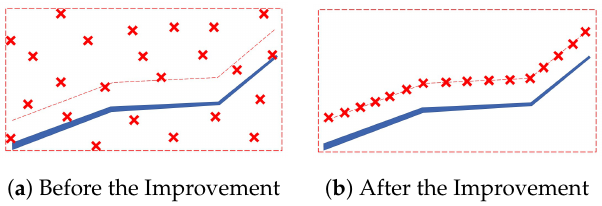
Figure 4. Sketch Map of Particle Initialization Improvement.